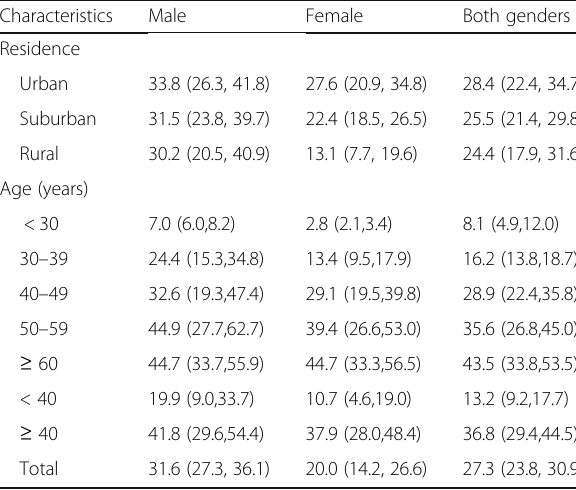
Table 2 Prevalence of hypertension in Nepal classified by area, age, and